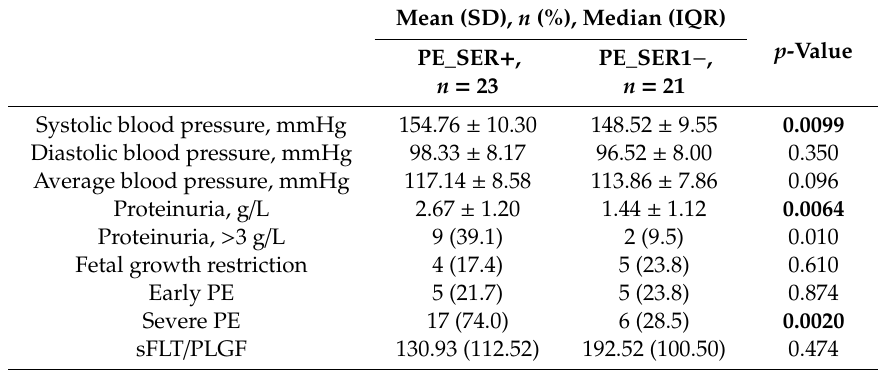
Table 2. Clinical features of patients of the PE_SER + group in comparison with PE_SER − group ( p -values less than 0.05 are in